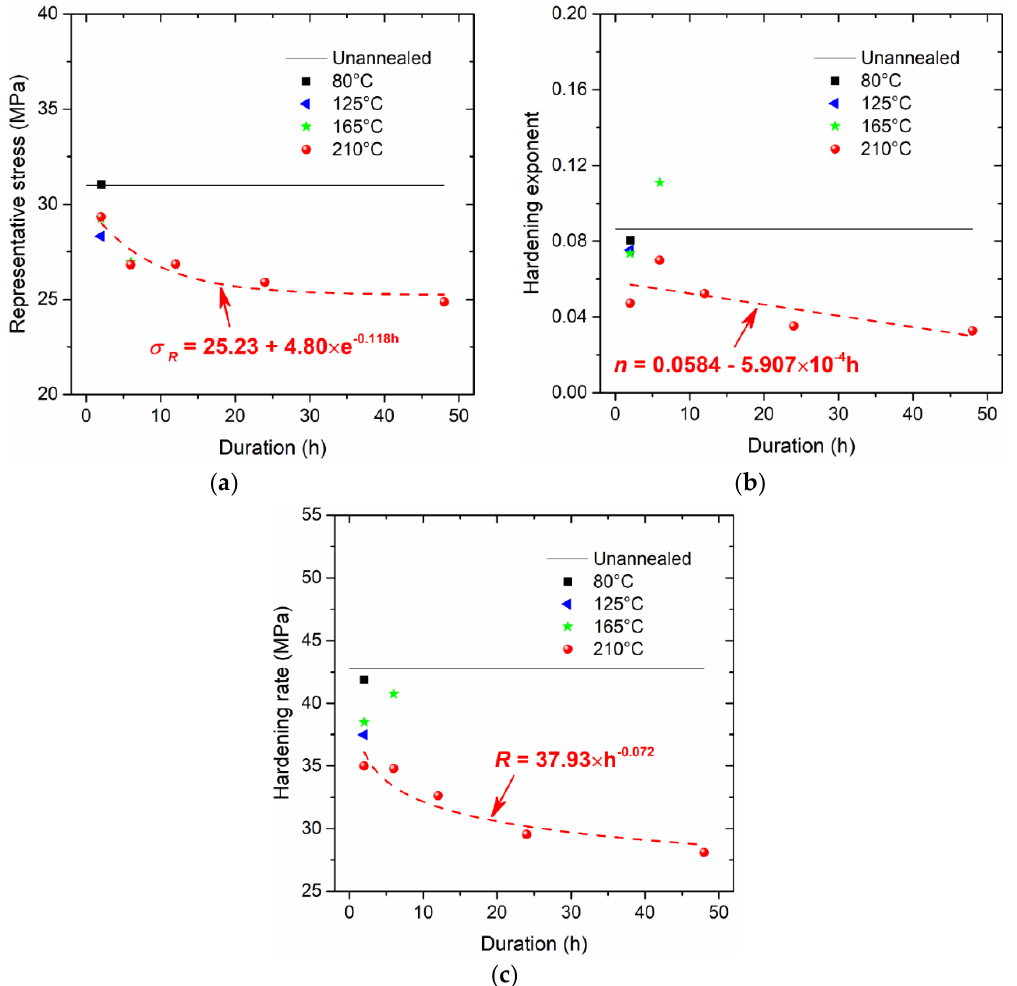
Figure 8. Critical parameters of constitutive model: ( a ) representative stress, ( b ) hardening exponent, and ( c ) hardening rate.